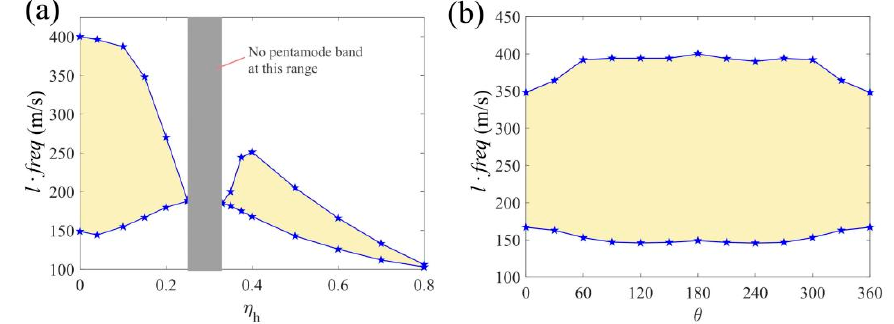
Figure 7. The relationship of ( a ) η h and ( b ) θ on pentamode bands.